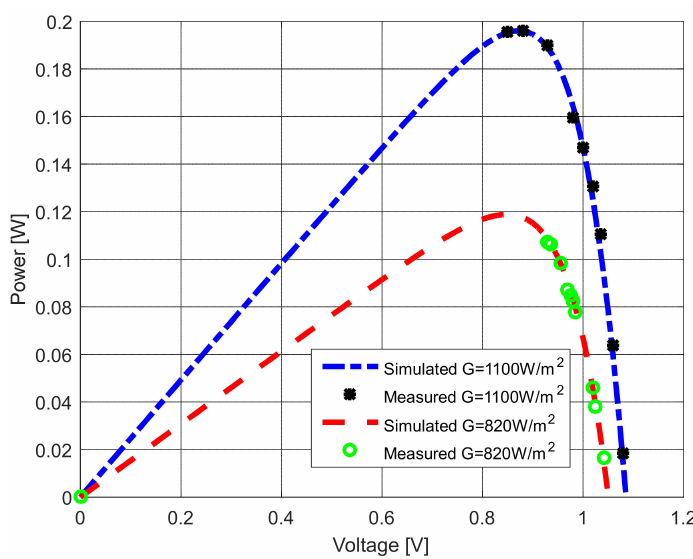
Figure 29. The measured and simulated P–U characteristics using different irradiance